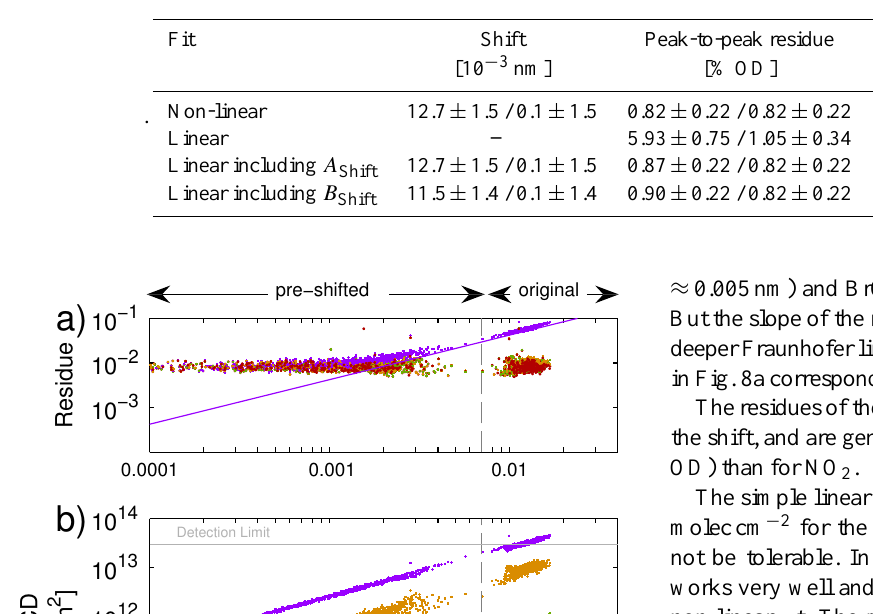
Table 5. Comparison of the results of the non-linear and the different linear fits applied to GOME-2 measurements on 12 April 2009. Spectral shift, fit residues, and BrO SCD bias are displayed as mean ± standard deviation, first for the original, then (separated by “/”) for the pre-shifted set of references.